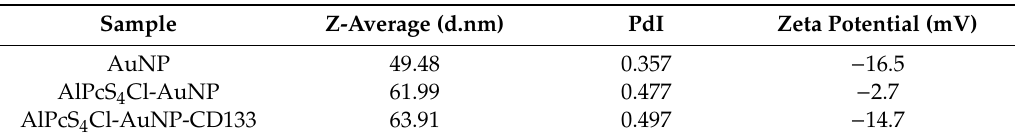
Table 2. DLS and LDV measurements of the single AuNP suspension, AlPcS 4 Cl-AuNP and AlPcS 4 Cl-AuNP- CD133.